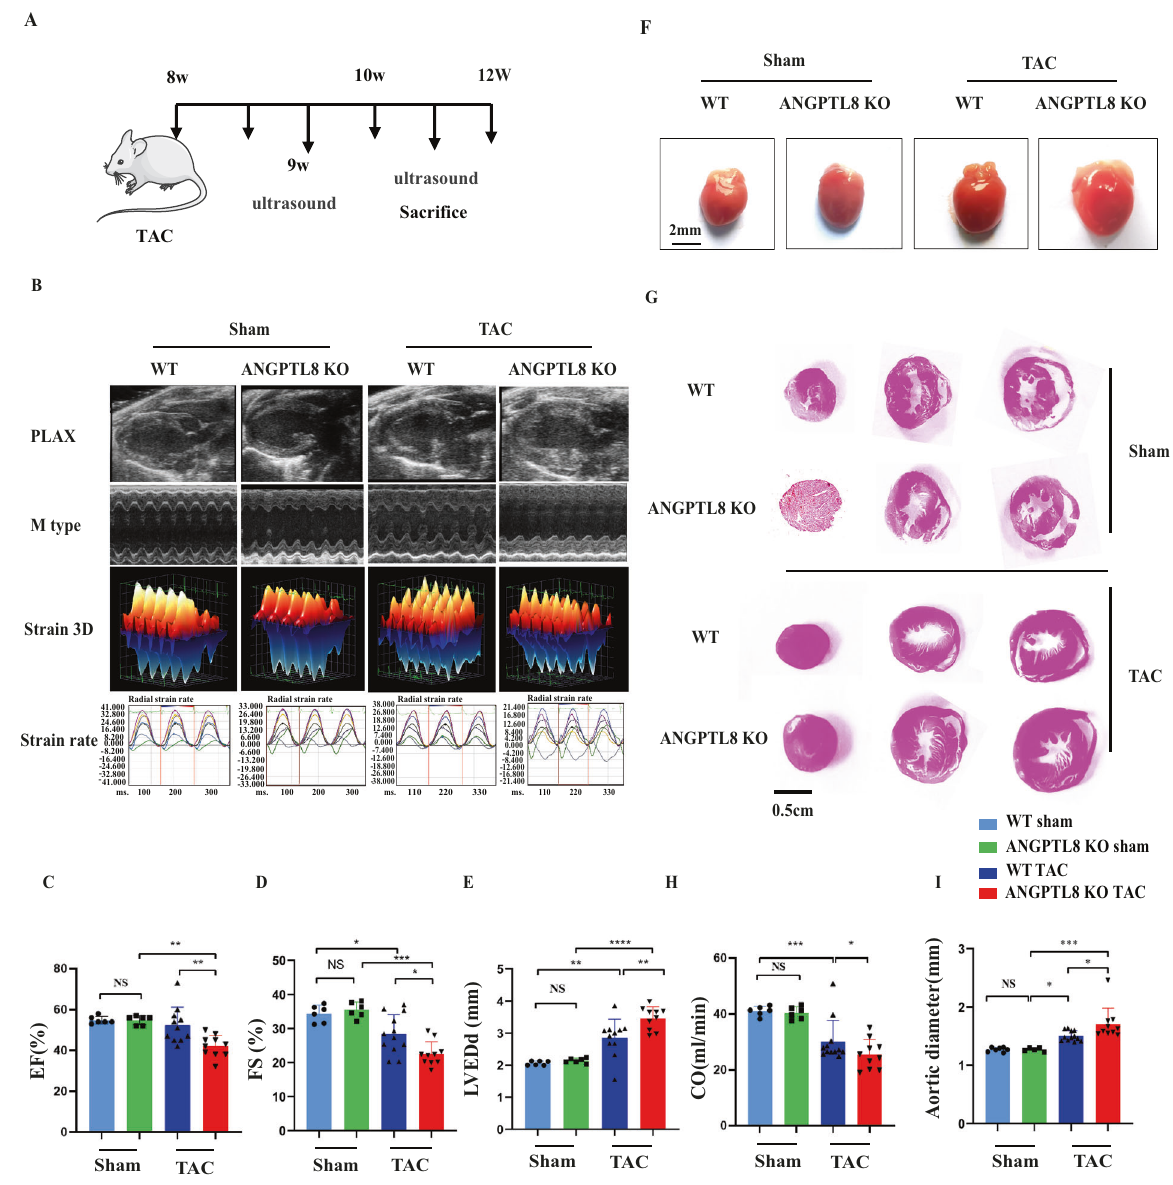
Fig. 5 ANTPTL8 knockout aggravated pressure overload-induced cardiac hypertrophy. A pressure overload-induced cardiac hypertrophy model was established by transverse aorta constriction (TAC) for 4 weeks. A Schematic diagram depicting TAC. B Echocardiographic detection of cardiac function in mice with myocardial hypertrophy at 4 weeks after TAC surgery, long axis of the heart (PLAX), M model (M type), and three-dimensional deformation ability (Strain3D & strain rate). C – E , H , I Echocardiographic assessments of EF%, FS%, LVEDd, cardiac output (CO) and aortic diameter (AD) in WT and ANGPTL8-KO mice at 4 weeks after sham ( n = 6 mice) or TAC surgery ( n = 9~10) (NS no statistical signi fi cance, *P < 0.05, ** P < 0.01, *** P < 0.001, **** P < 0.0001). F Representative images of the gross cardiac morphology of WT and ANGPTL8- KO mice in the indicated groups. G Representative images of H&E staining from transverse sections of the left ventricles from the indicated groups ( n = 5 mice for each group, scale bar, 0.5 cm).